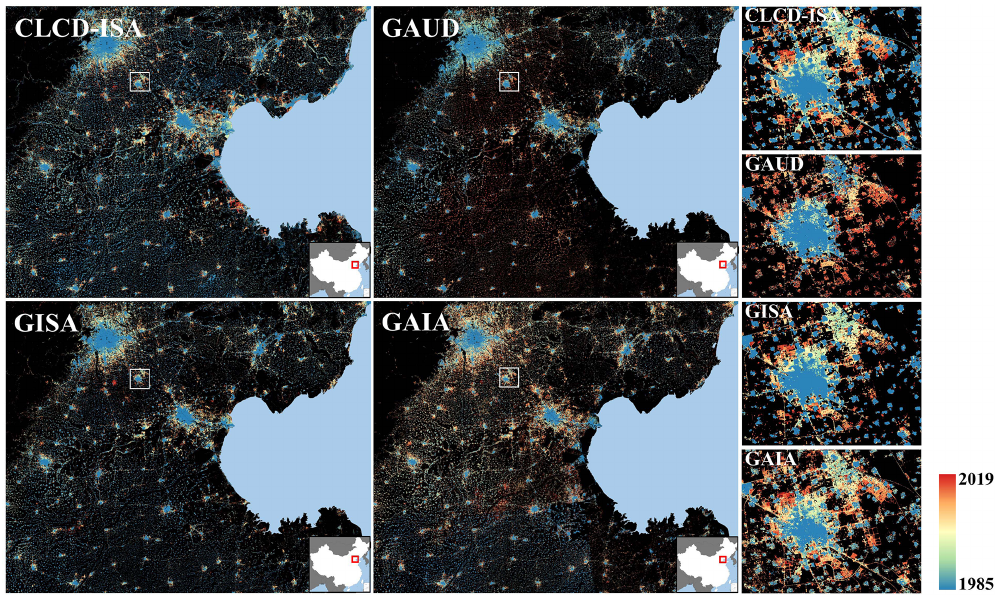
Figure 7. Comparison between different ISA products over the North China Plain, with close-up maps located in Langfang city (39.526545 ◦ N, 116.703692 ◦ E).